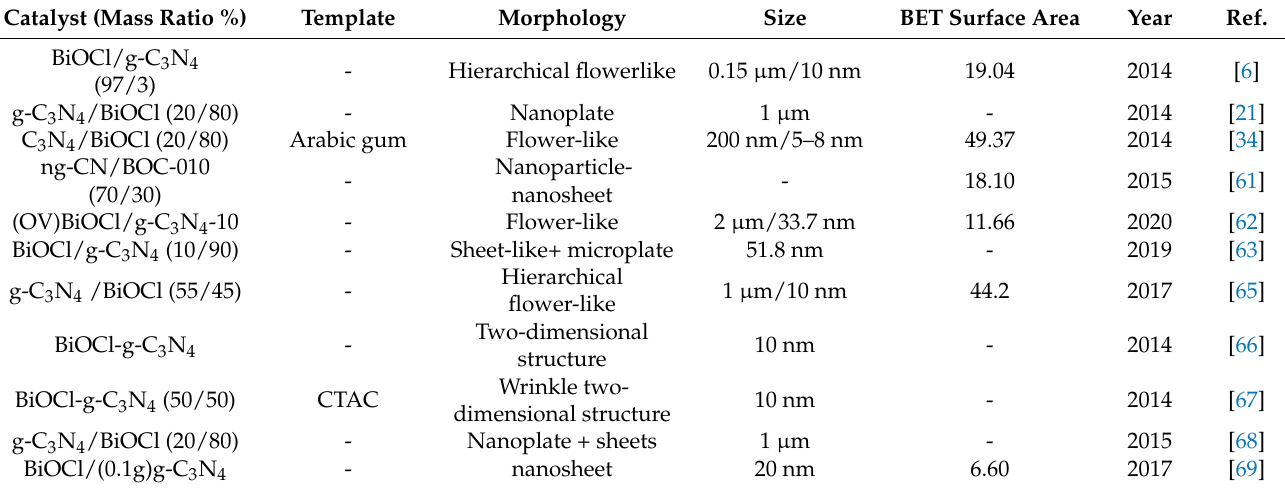
Table 2. G-C 3 N 4 /BiOCl heterojunctions synthesized by deposition–precipitation